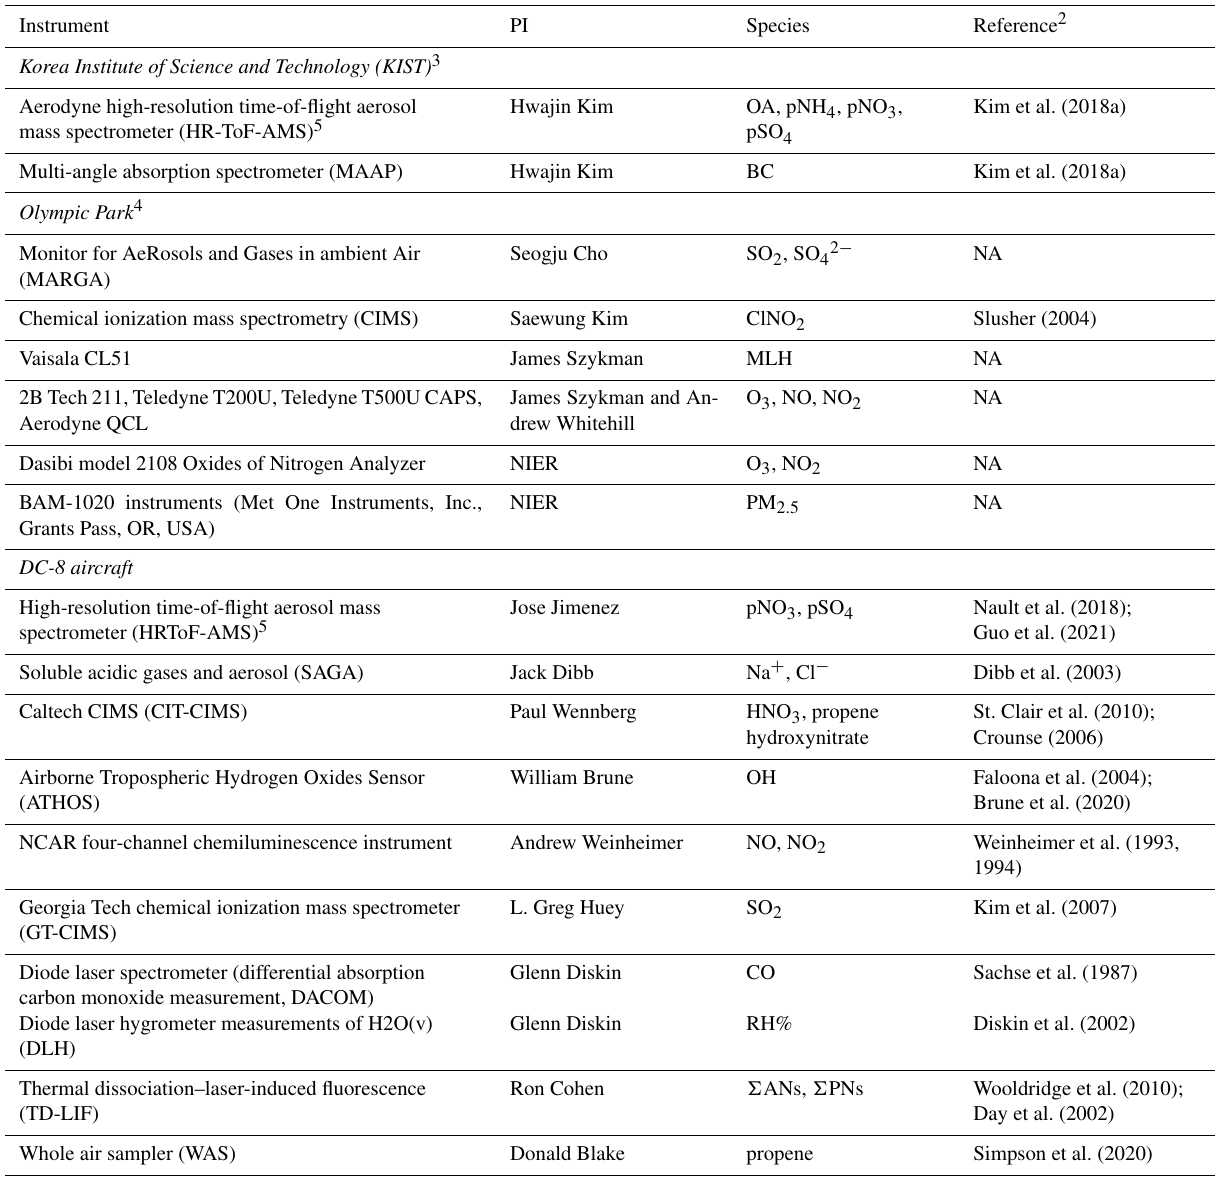
Table 1. Description of the ground site and aircraft observations used in this work 1 . Instrument PI Species Reference 2